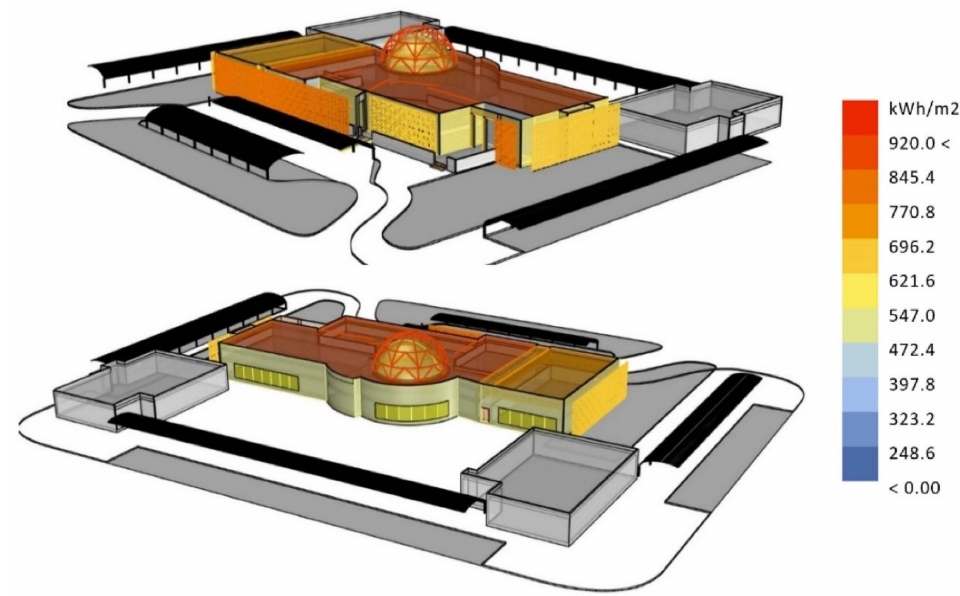
Figure 14. Energy calculation of the retrofitted model.